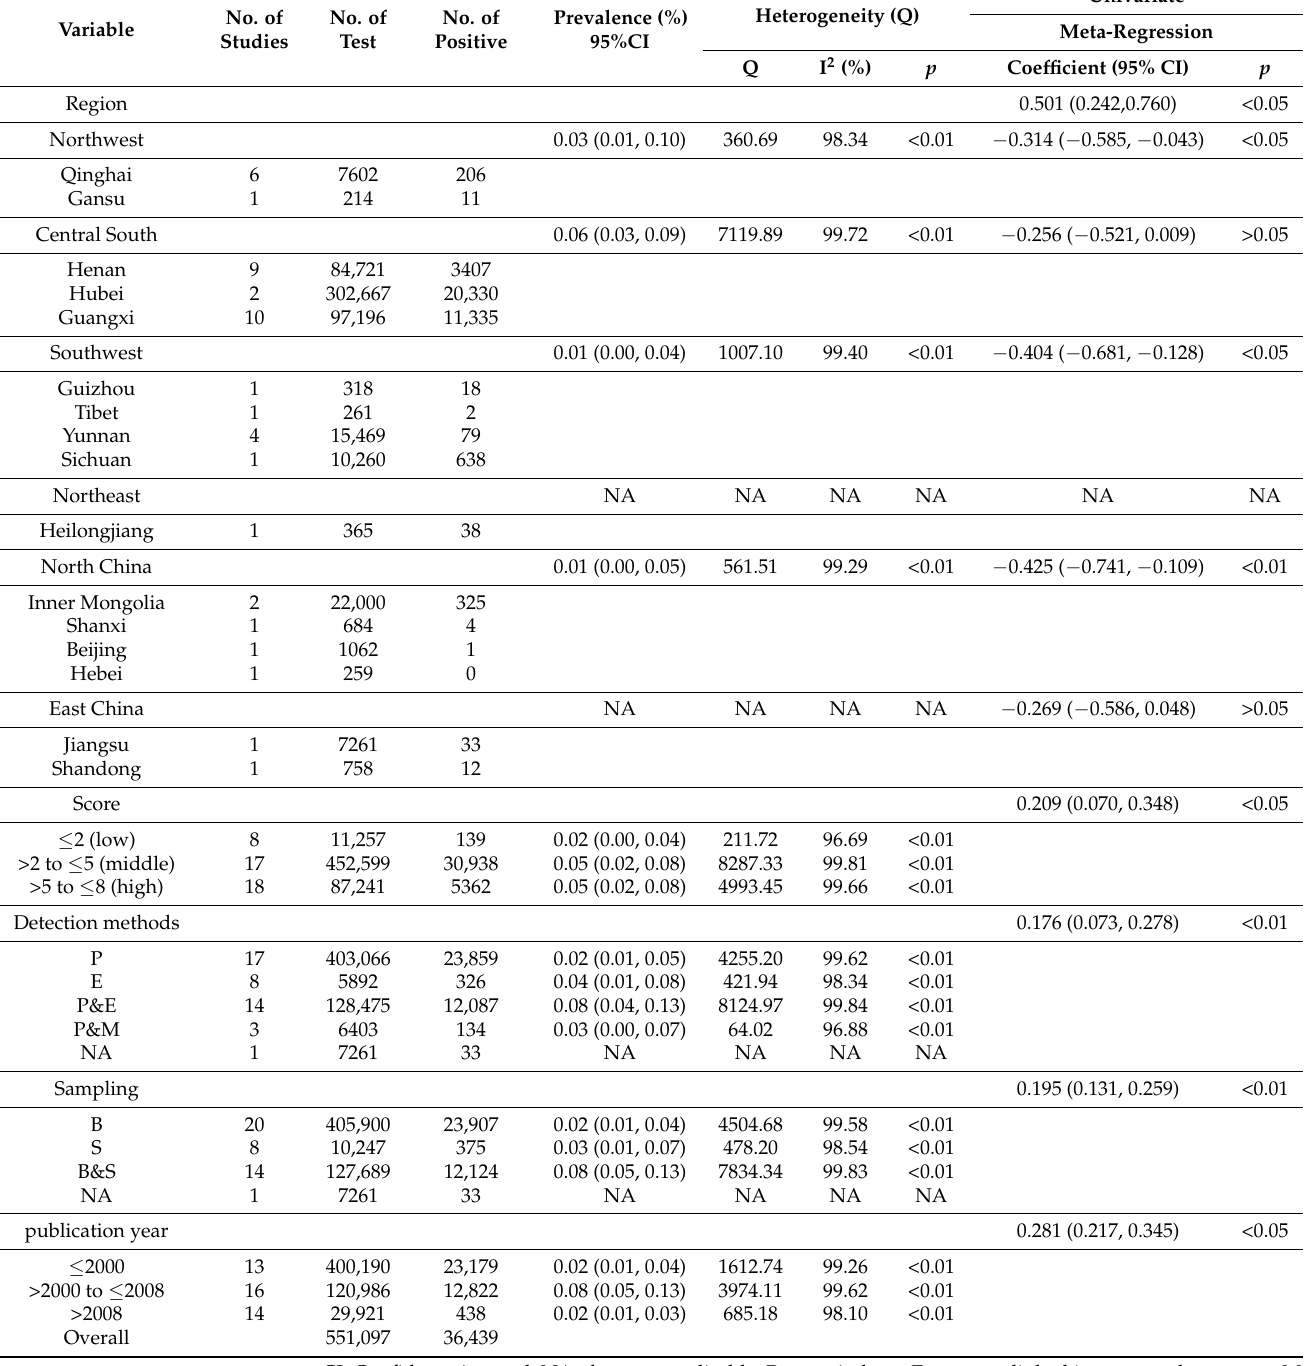
Table 2. Pooled prevalence of risk factors in Trichinella spiralis infection in domestic pigs in